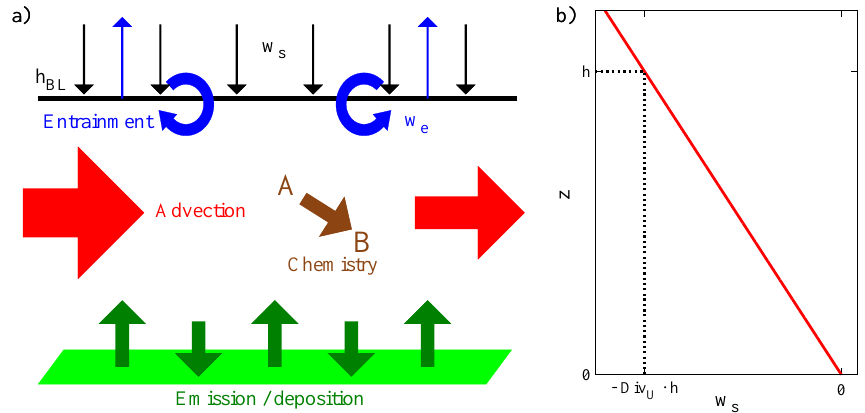
Fig. 19. (a) Schematic overview of the different terms that affect the evolution of scalars and the boundary layer height. Shown are the emis-